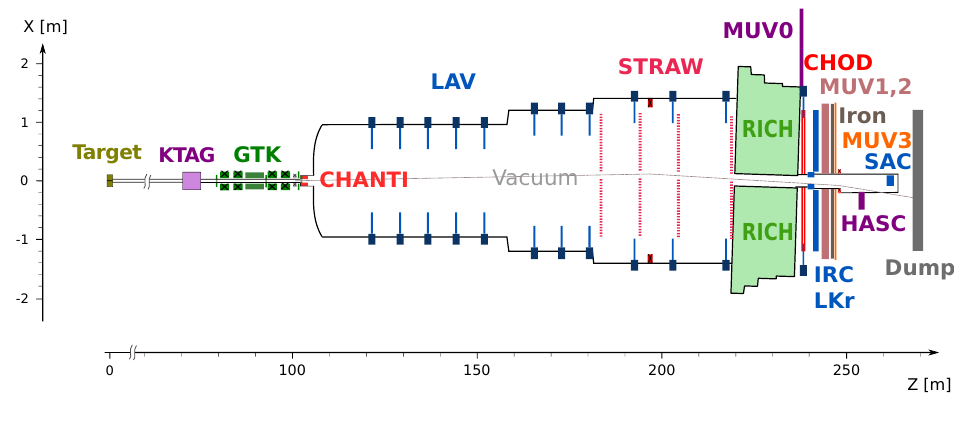
Figure 1 . Schematic top view of the NA62 beam line and detector. The trajectory of a beam particle is shown, travelling in vacuum and crossing the detector apertures. A dipole magnet between the MUV3 and SAC systems de(cid:13)ects beam particles out of the SAC